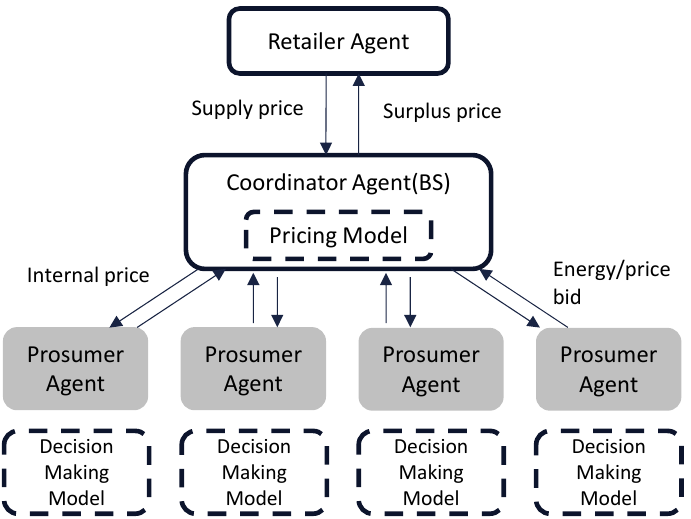
Figure 8. Overview of the multiagent-based simulation framework, source [56].